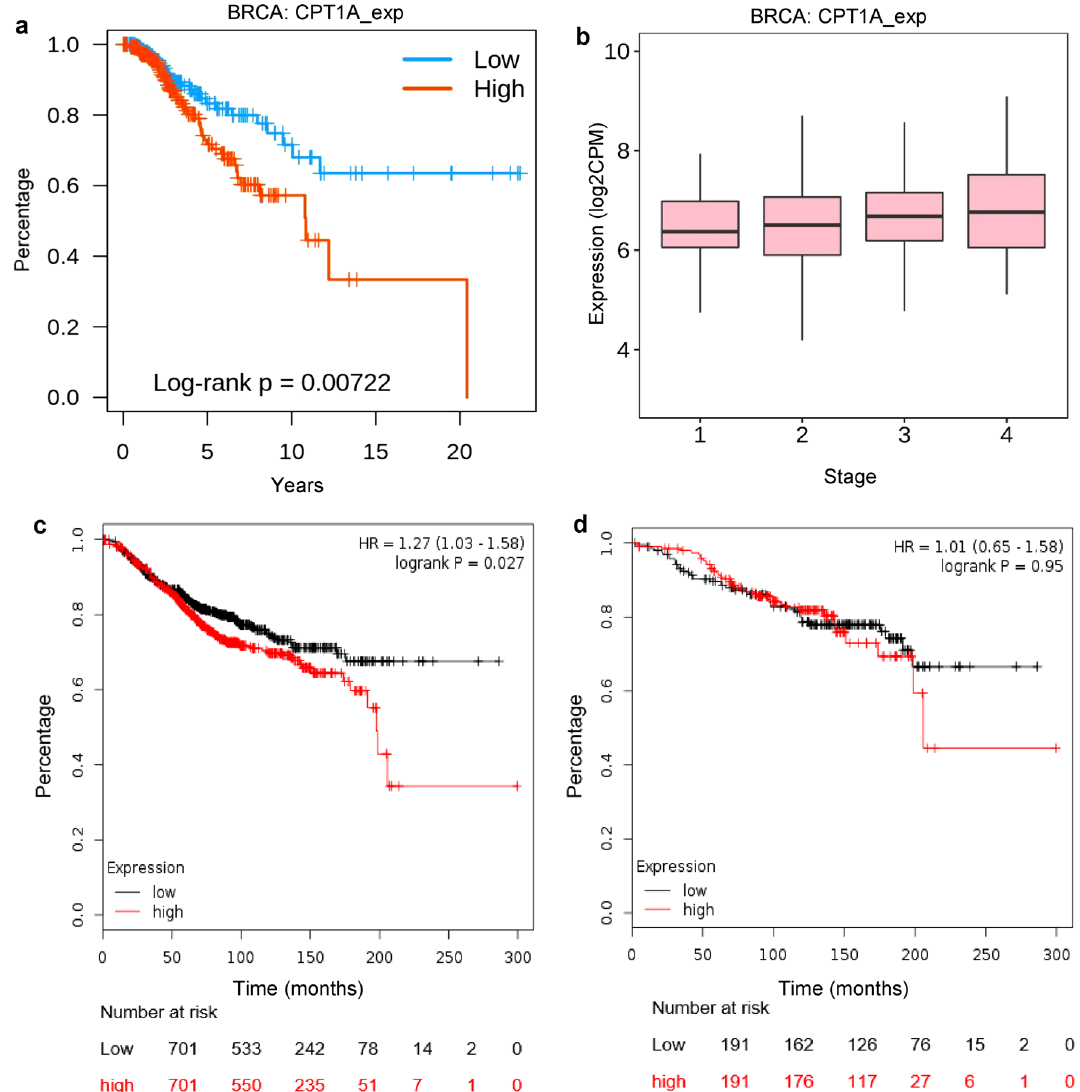
Figure 1. CPT-1A expression and clinical outcome in breast cancer. Kaplan–Meier graphs showing difference in overall survival of breast cancer patients with high and low expression of CPT-1A ( a ), correlation of CPT1A expression to disease stage depicted in box plot ( b ), spearman: rho = 0.089, p = 0.00355 and differences in overall survival of treated patients ( c ) vs. untreated patients ( d